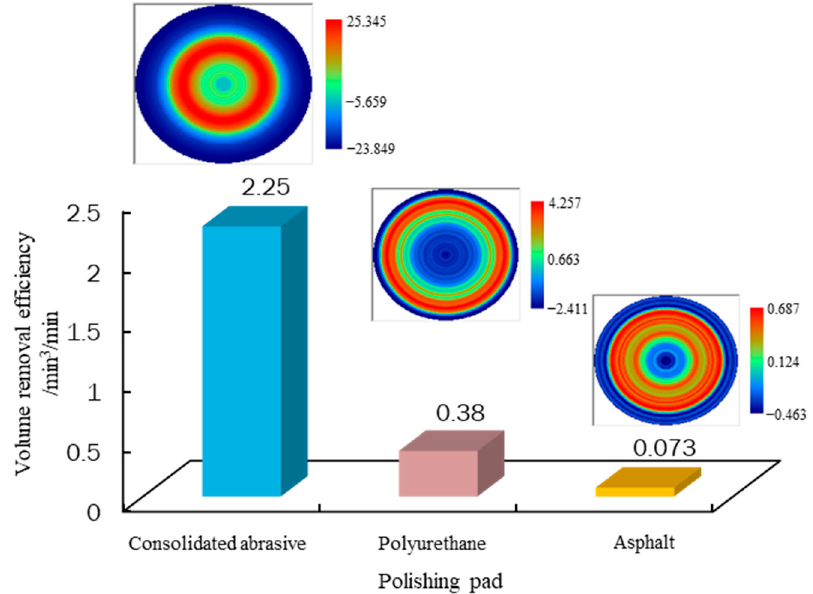
Figure 7. Comparison of the removal e ffi ciency of di ff erent polishing tools.